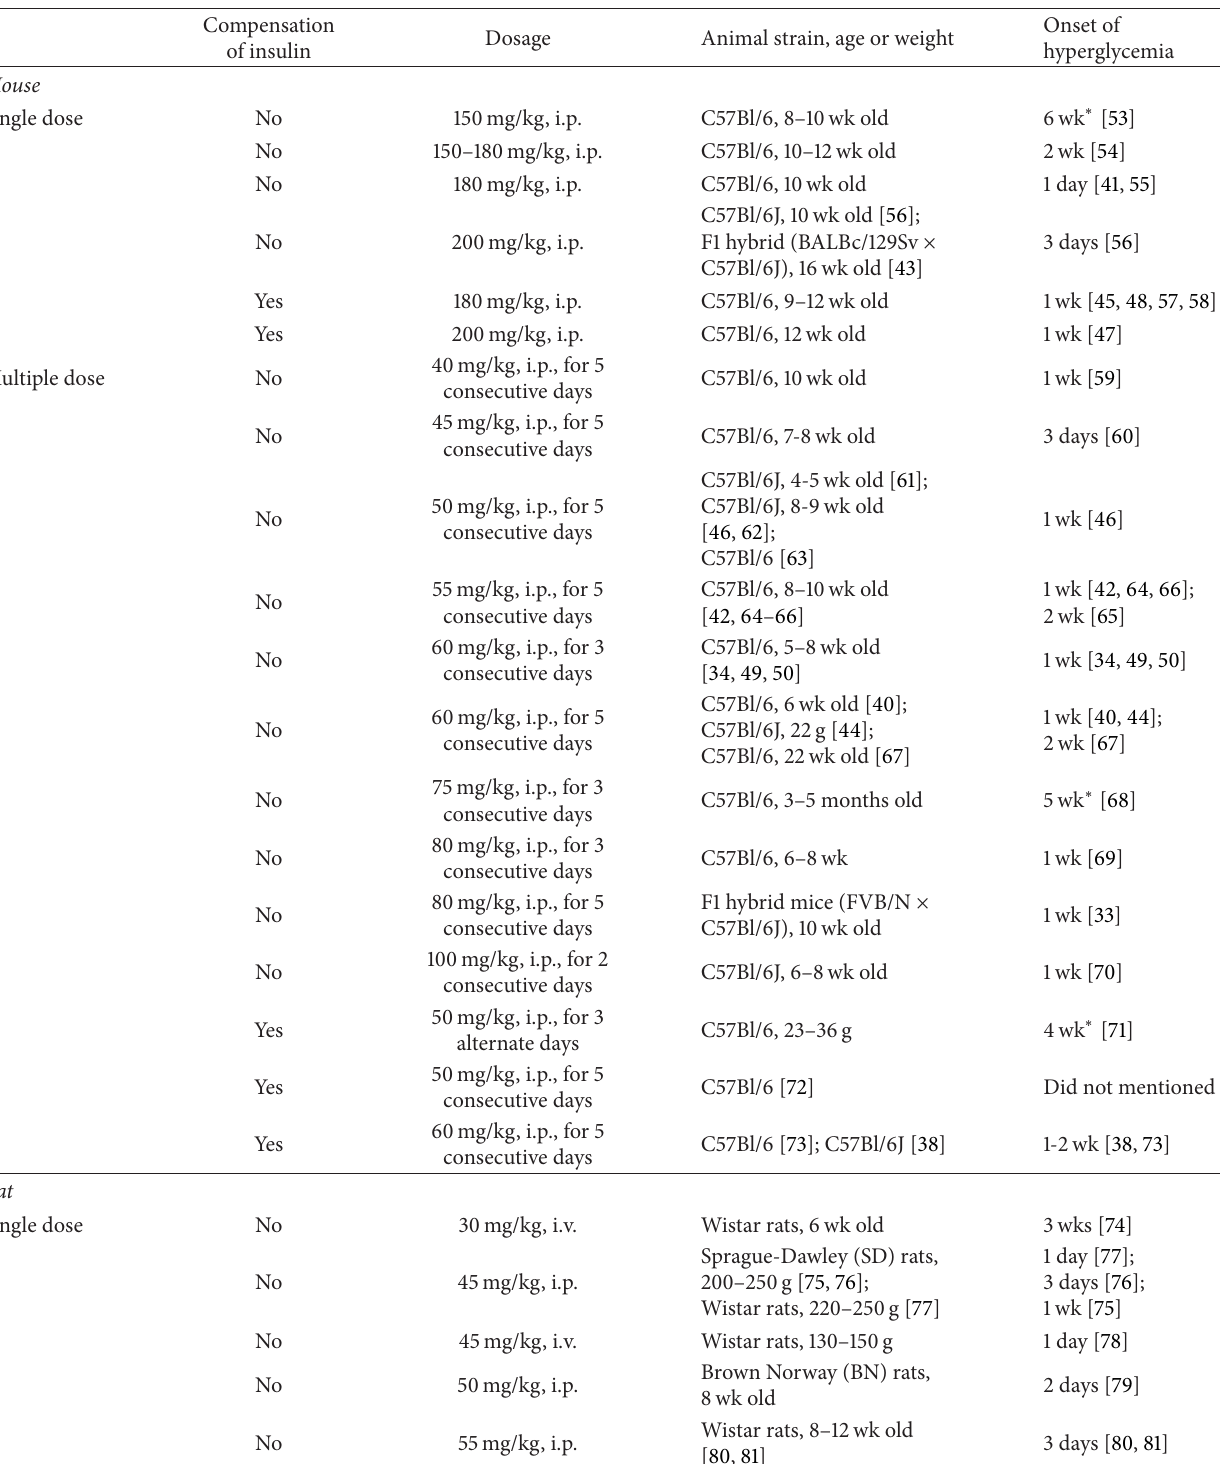
Table 1: Existing methods for induction of diabetes in rodents using